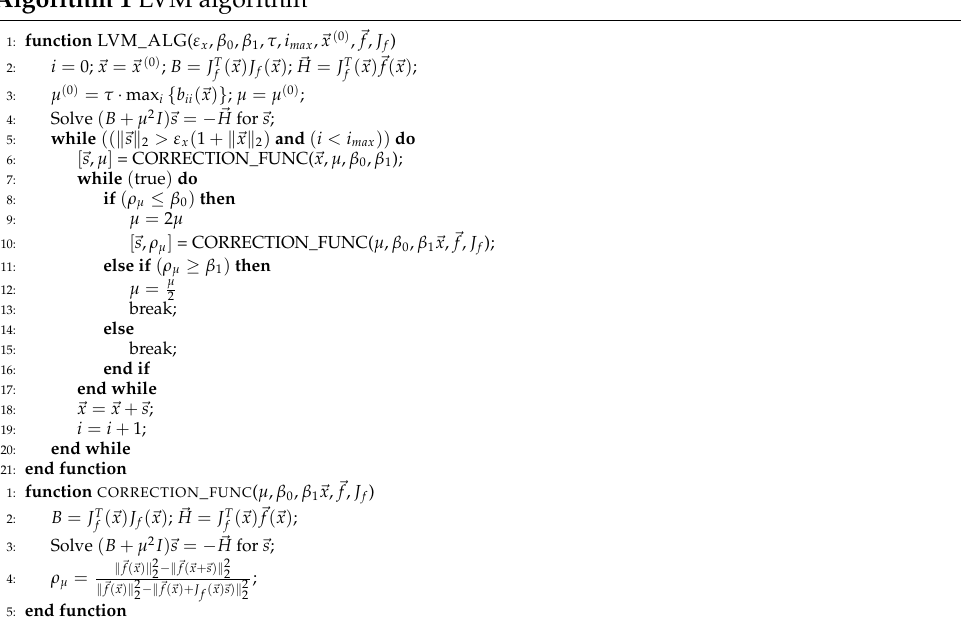
Algorithm 1 LVM